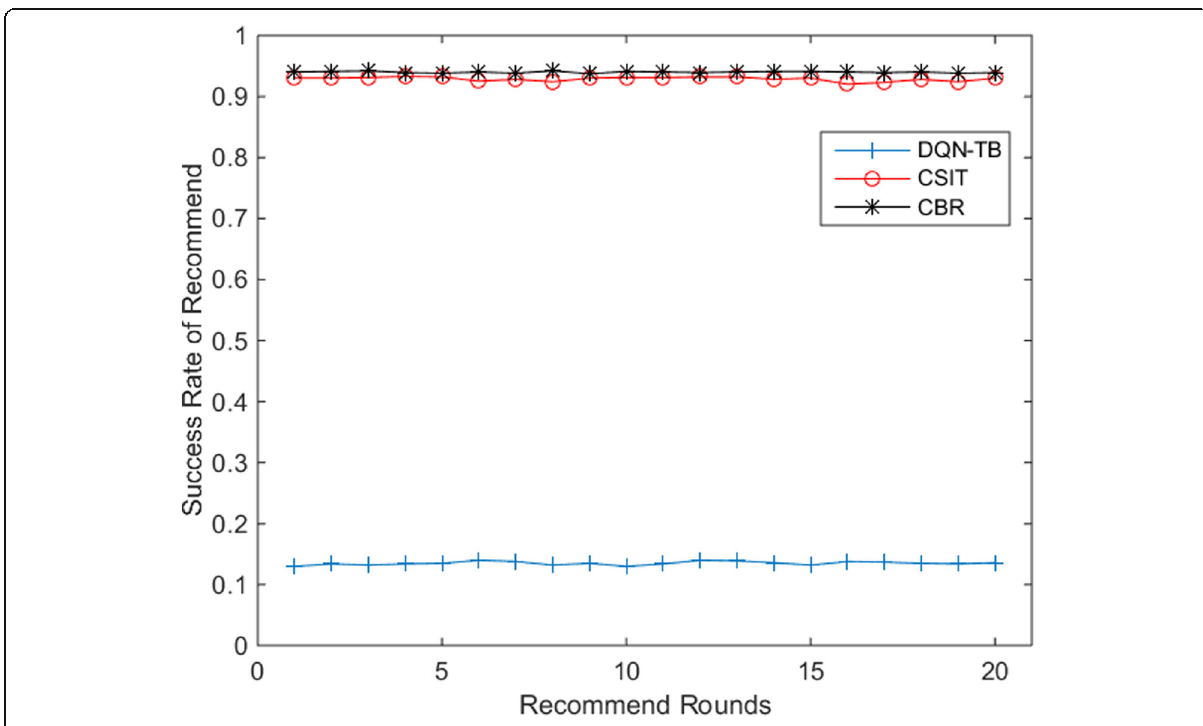
Fig. 12 Change of success rate with no dynamic change